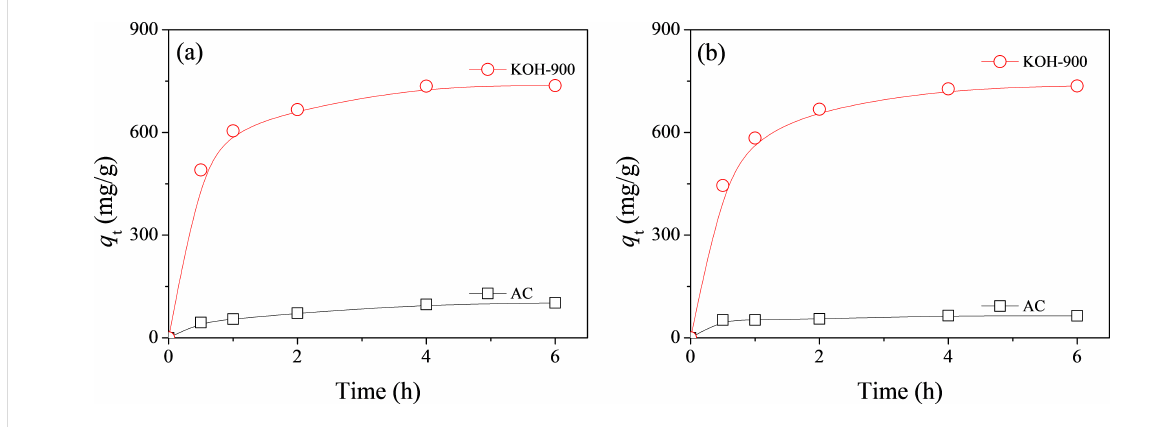
Figure 5: Effect of contact time on (a) AR1 and (b) JGB adsorption over AC and KOH-900.